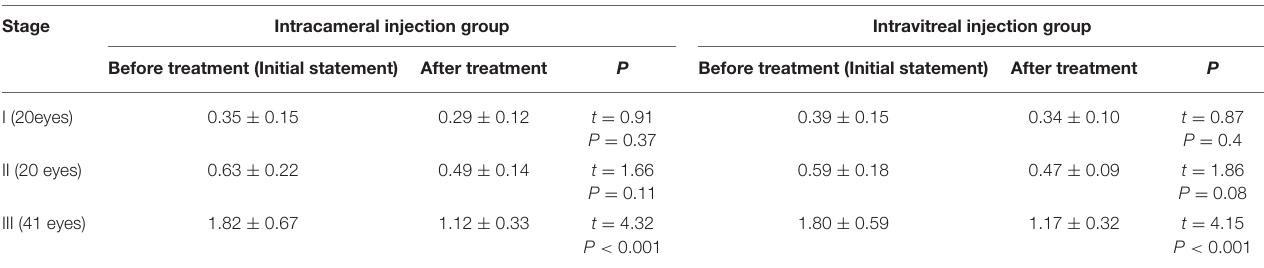
TABLE 3 | The best-correct visual acuity (Log MAR) before and after